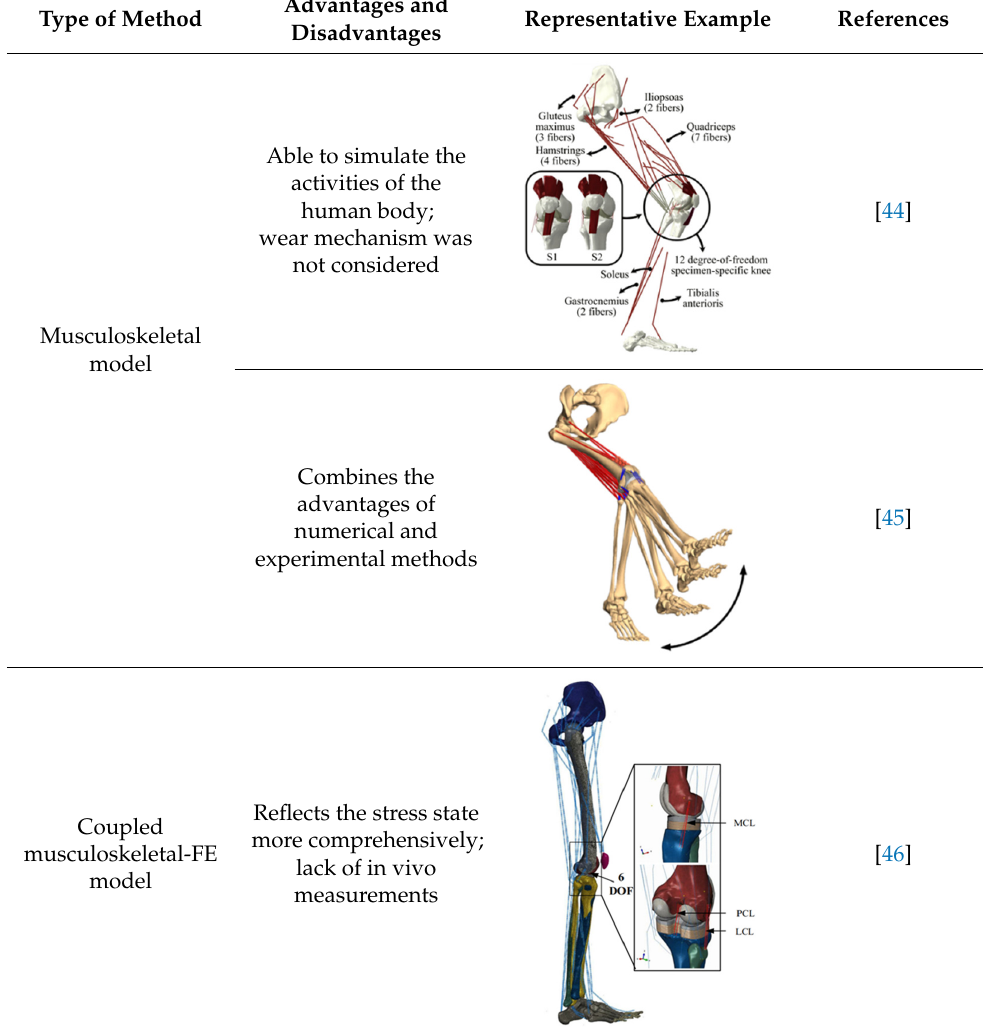
Table 6. A summary of the in silico methods for evaluating the performance of knee joint replacements. Type of